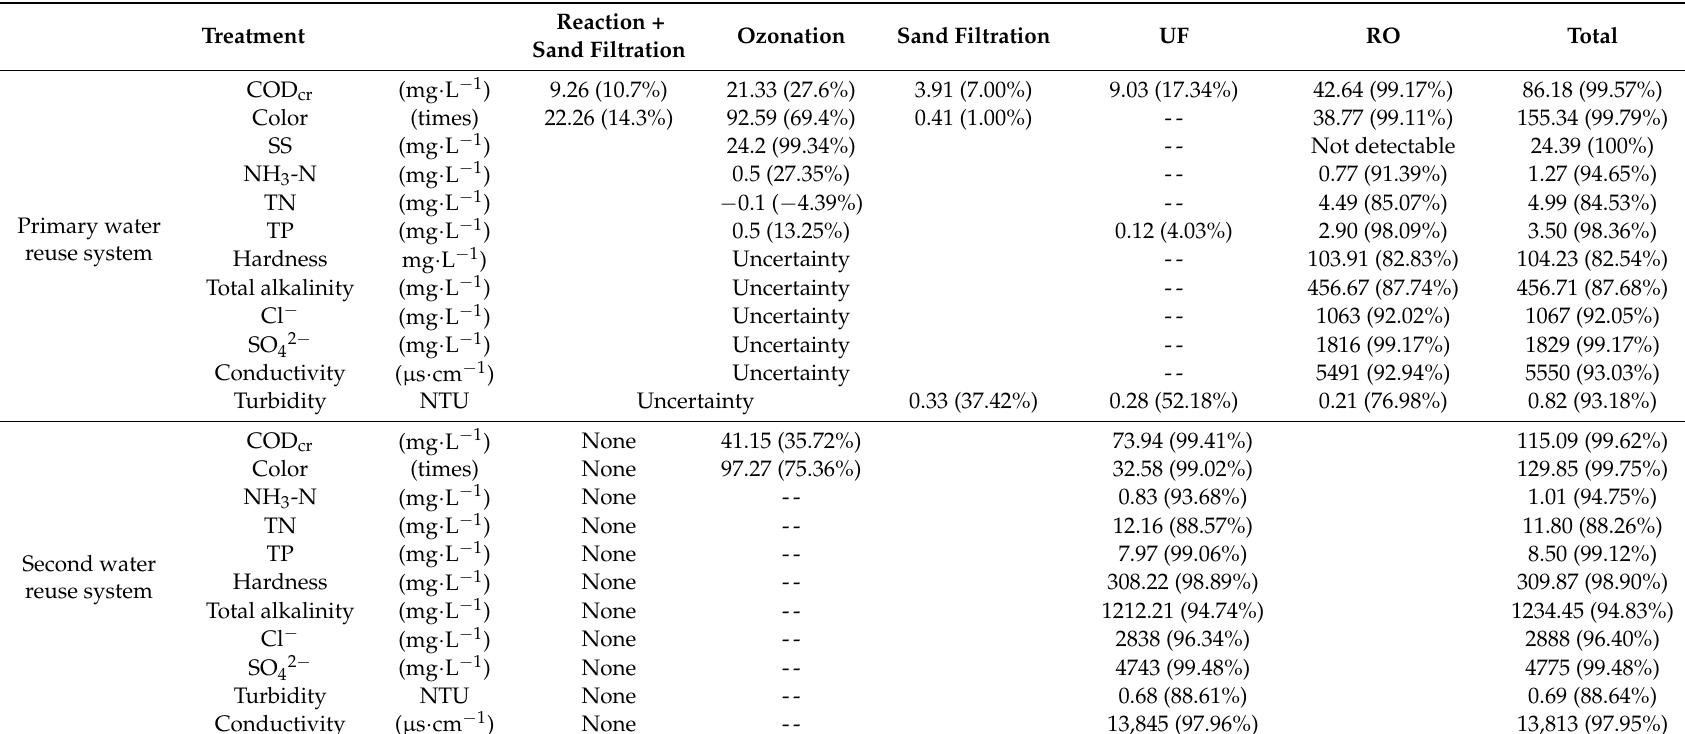
Table 5. Summary of results of combined process as indicated by average drop and removal